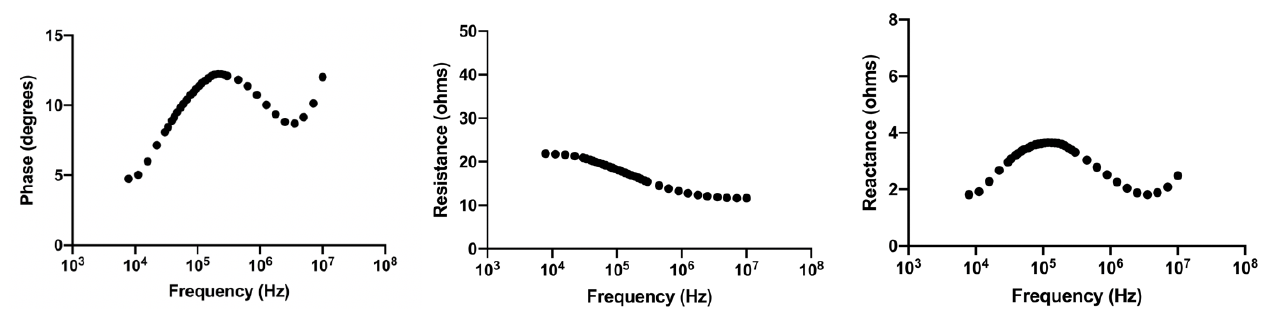
Figure 2. Typical multifrequency data obtained from with the mView impedance-measuring system shown in Figure 1. This data is from a 34-year- old healthy